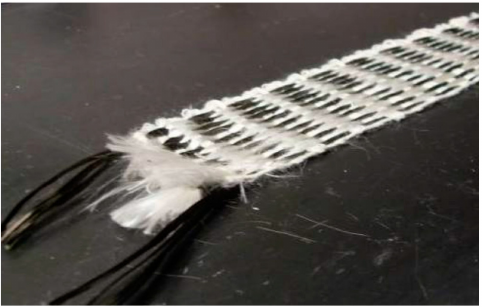
Figure 26. The image of carbon fiber textile. Reproduced with permission from [75], MDPI,